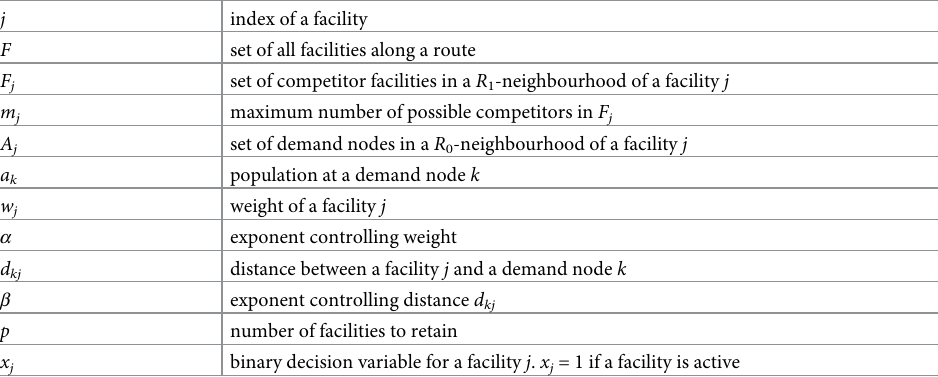
Table 2. Notation for all variables used in the